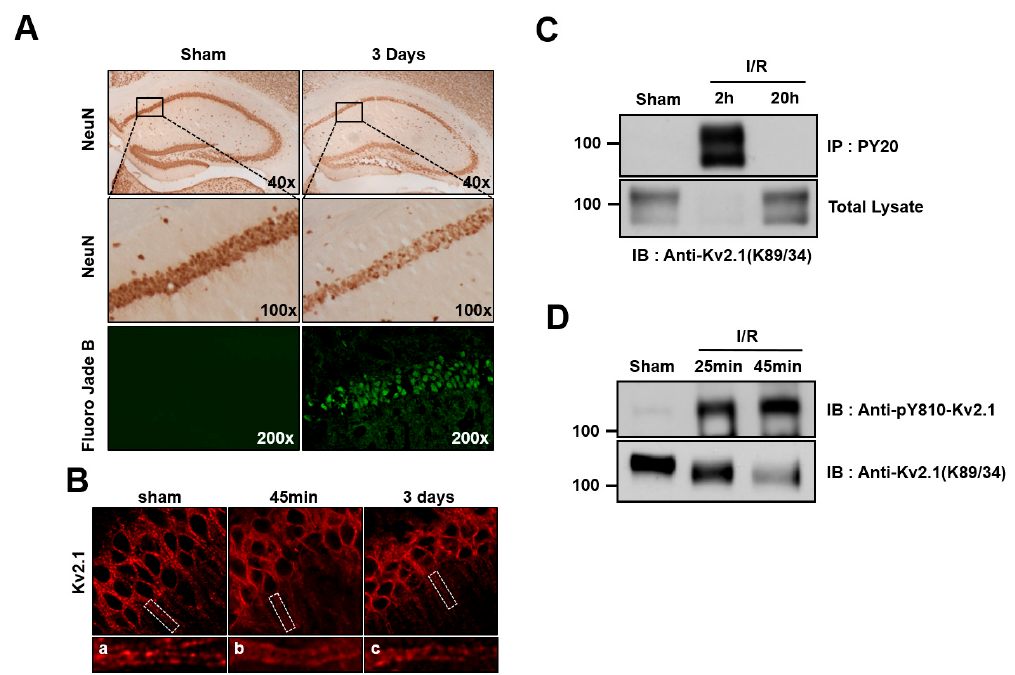
Figure 4. Tyrosine phosphorylation of the K v 2.1 channel after ischemia/reperfusion. ( A ) Representative photographs of brain sections labeled with NeuN and Fluoro-Jade B (green) 3 days after ischemia/reperfusion injury (20 min). NeuN labeling (top and middle panel) of the hippocampus in control rats and those with ischemia/reperfusion injuries. Middle panel is the magnification of the boxed areas shown in the top panel. Cells positively stained for Fluoro-Jade B were identified as apoptotic neurons. Fluoro-Jade B-labeled cells (bottom panel) were present in CA1 pyramidal neurons undergoing apoptosis. ( B ) Clustering of the K v 2.1 channel on the soma and dendrites of a control rat brain (left). Dispersion of K v 2.1 clusters 45 min after ischemia / reperfusion (middle). Three days after ischemia / reperfusion, the clustering of K v 2.1 was restored (right). Panels a-c are magnified views of the boxed areas in the top panel. ( C ) Brain membrane fractions isolated from control rats and rats subjected to 4 VO 2 and 20 h after ischemia / reperfusion were immunoprecipitated with anti-pY20. The immunoprecipitates were separated by 7.5% SDS-PAGE and immunoblotted with anti-K v 2.1 mAb. ( D ) Membrane lysates from the hippocampus isolated from control mice and mice subjected to two-vessel occlusion 25 min and 45 min after ischemia / reperfusion were immunoblotted with anti-pY810-K v 2.1 or anti-K v